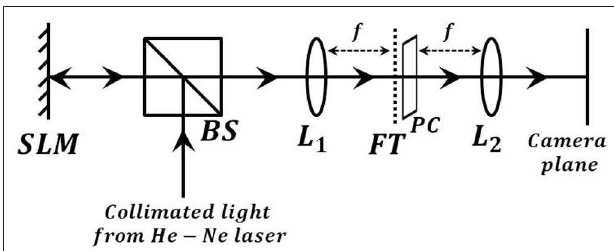
FIGURE 11 | Schematic of setup for multiple beam interference. SLM, spatial light modulator; BS, beam splitter; L 1 , L 2 , lenses; FT, Fourier transform plane; PC, polarization convertor; Camera